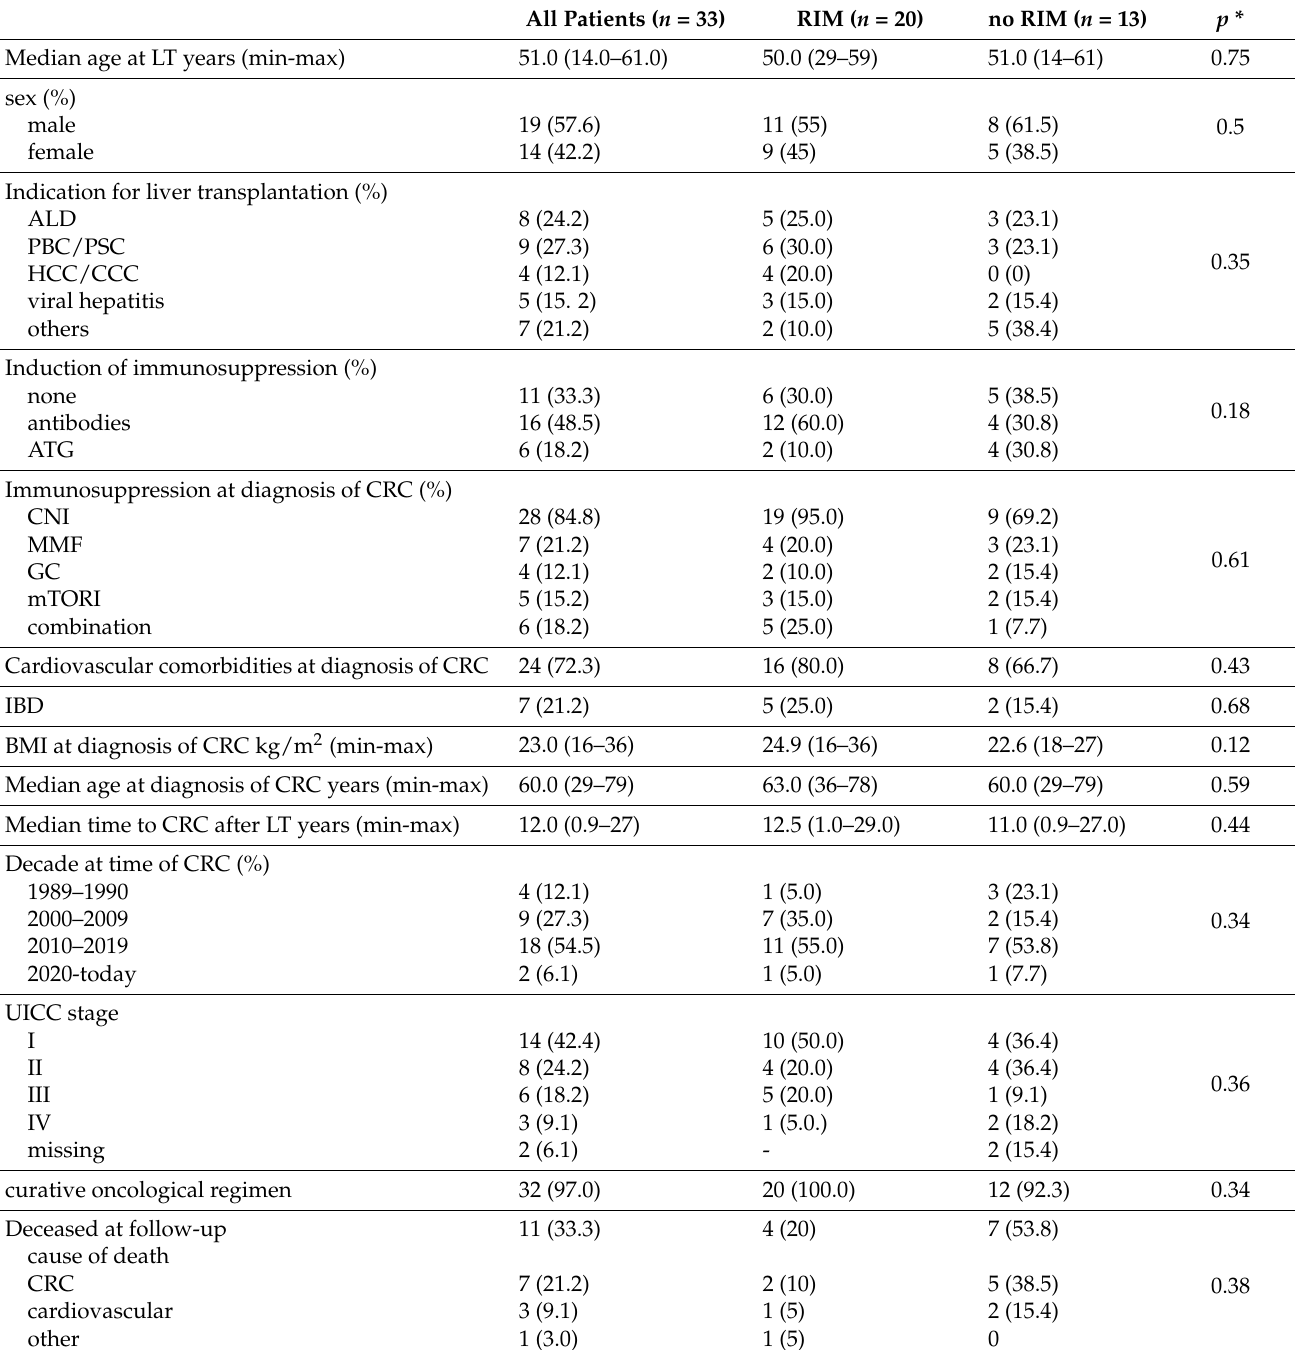
Table 1. Overall cohort and Group